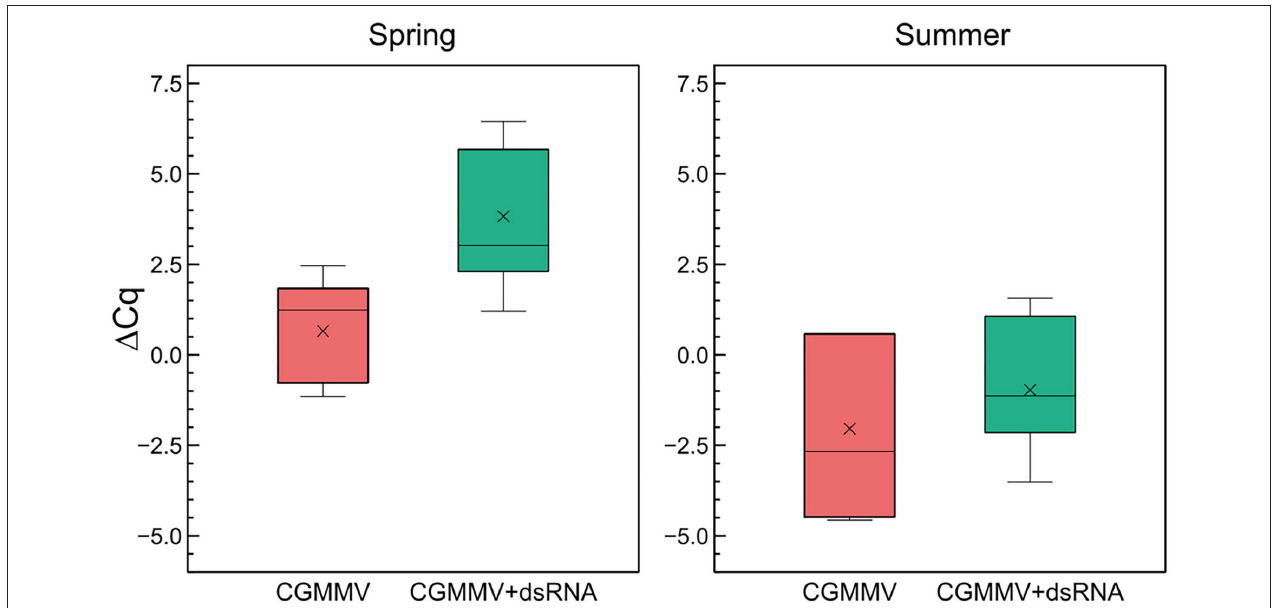
FIGURE 3 | Quantitative differences in CGMMV accumulation between dsRNA-treated and untreated infected plants in two greenhouse assays carried out in spring and summer. The 1 Cq refers to the differences between the averages of the Cq of the virus of the cp gene and the average Cq of the internal rRNA 18S control of cucumber. Lower 1 Cq cp − 18S values mean a higher dsRNA titer. Each boxplot shows the median (horizontal line), first, and third quartiles (lower and upper limits of boxes), and the minimum and maximum values (delimited by the external whiskers). Mean values are indicated by